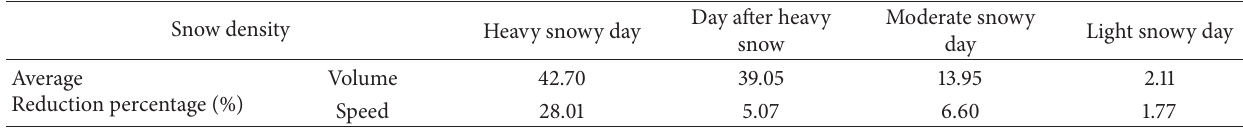
Table 4: Reduction coefficients of traffic flow parameters under various snow